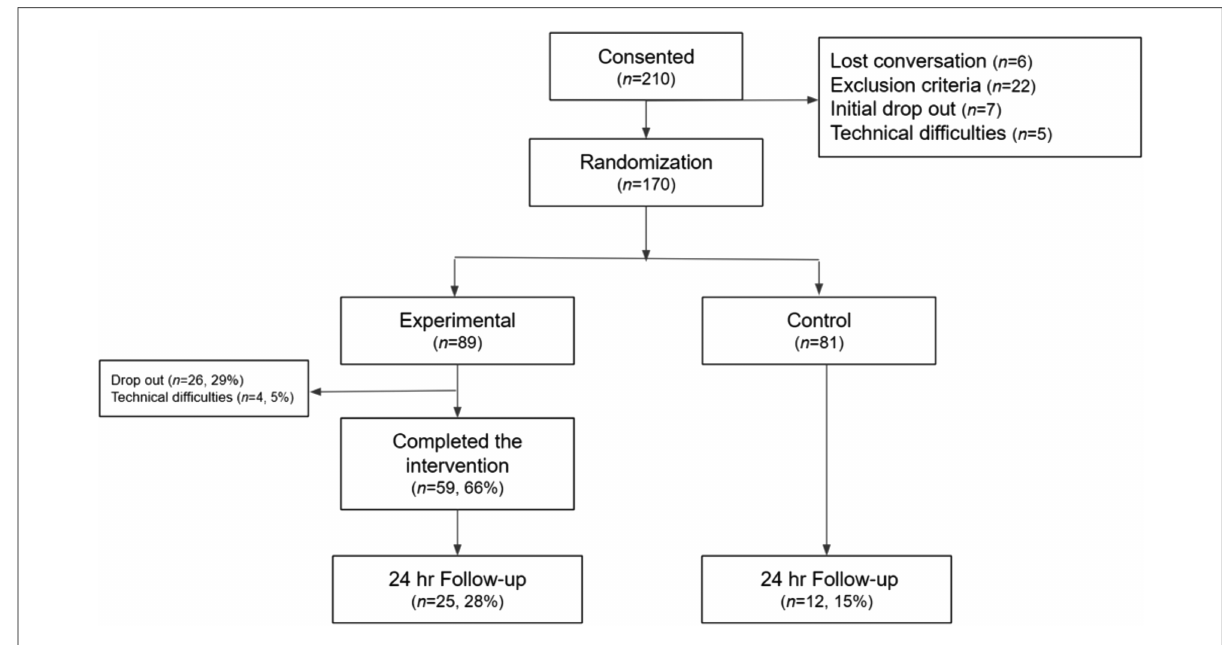
FIGURE 3 Flow of participants through the